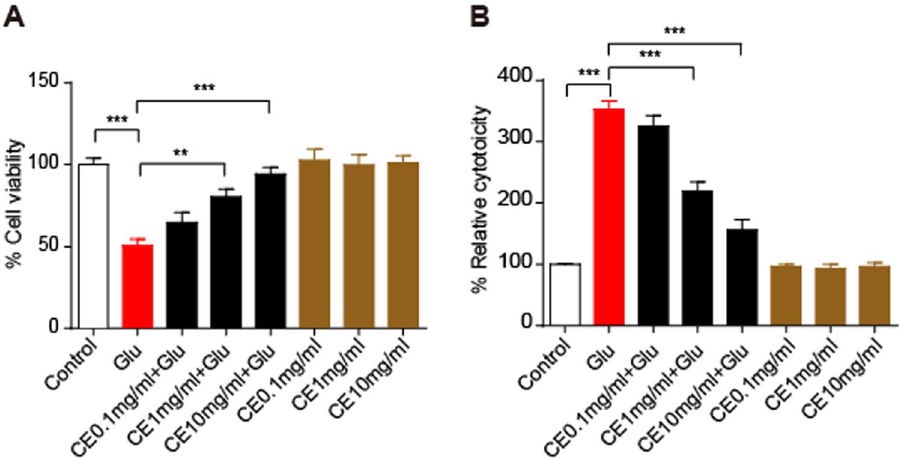
Figure 1. CE protects against glutamate-induced neurotoxicity. Primary cortical neurons were cultured for 7 days and then treated with 0.1, 1 and 10 mg/ml CE in the presence or absence of 100 μ M glutamate for 24 hours. ( A ) Cell viability was measured using the MTT assay (n = 5). ( B ) Cytotoxicity was tested using the LDH release assay (n = 5). Glu, glutamate. Data are shown as mean ± SEM from 3 individual experiments; One-way